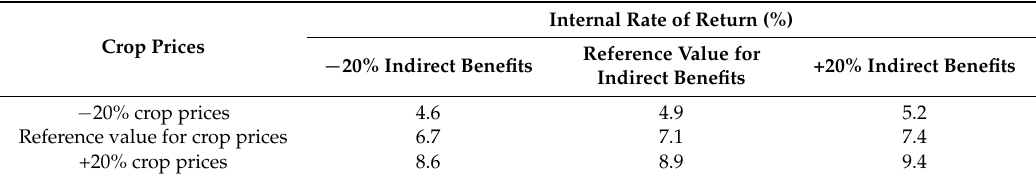
Table 8. Sensitivity analyses for the effects of changing crop prices and changing indirect